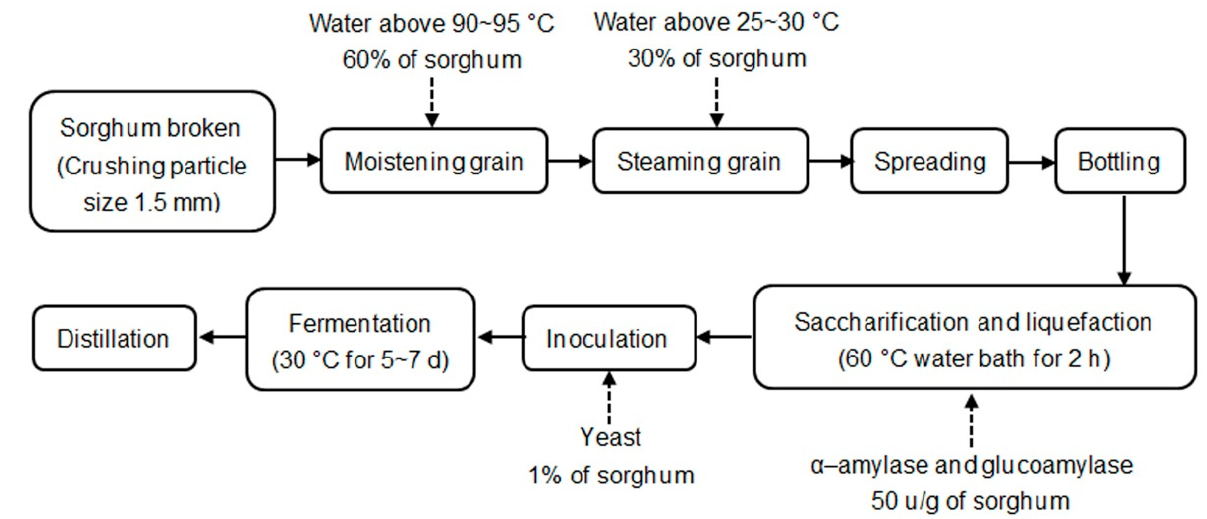
Figure 1. The process of simulated liquid state fermentation of Chinese baijiu.